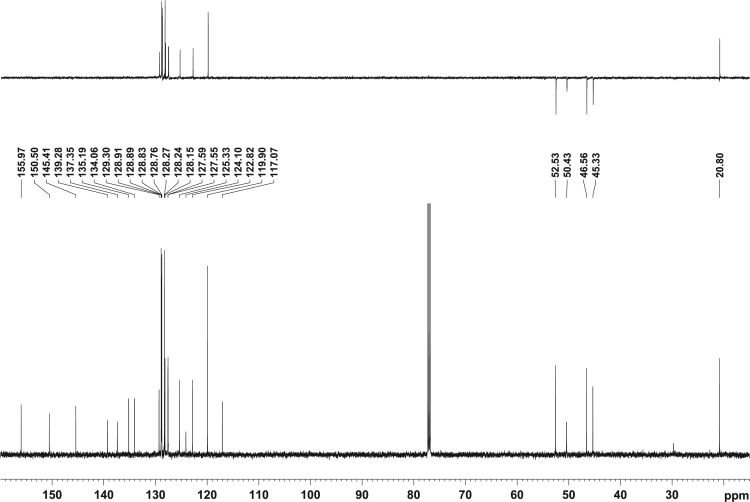
13C NMR spectrum of ligand S2.